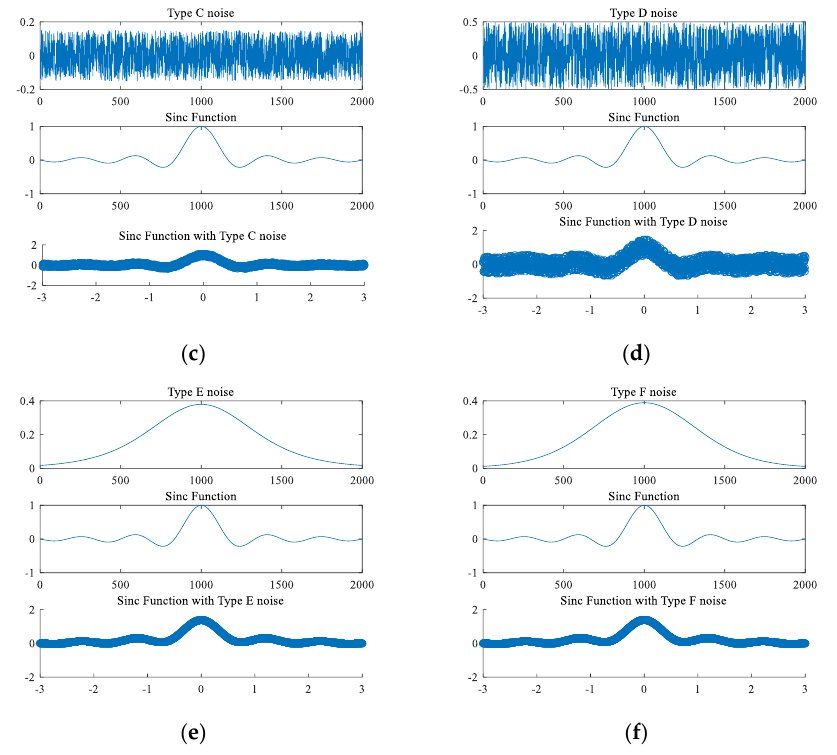
Figure 2. Graphs of the sinc function with different noises. Figure 3 shows different types of noise graphs, the graphs of the self-defining function, and the graphs of the self-defining function with different noises.